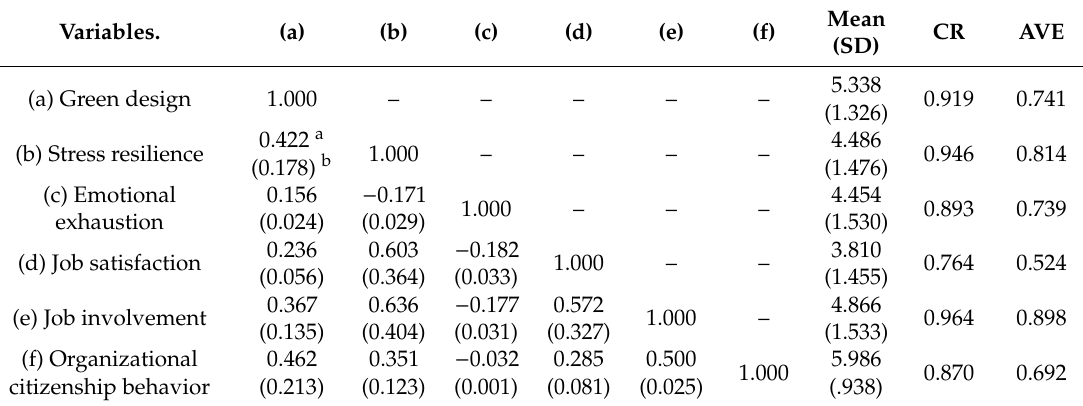
Table 1. Measurement model estimation results ( n =